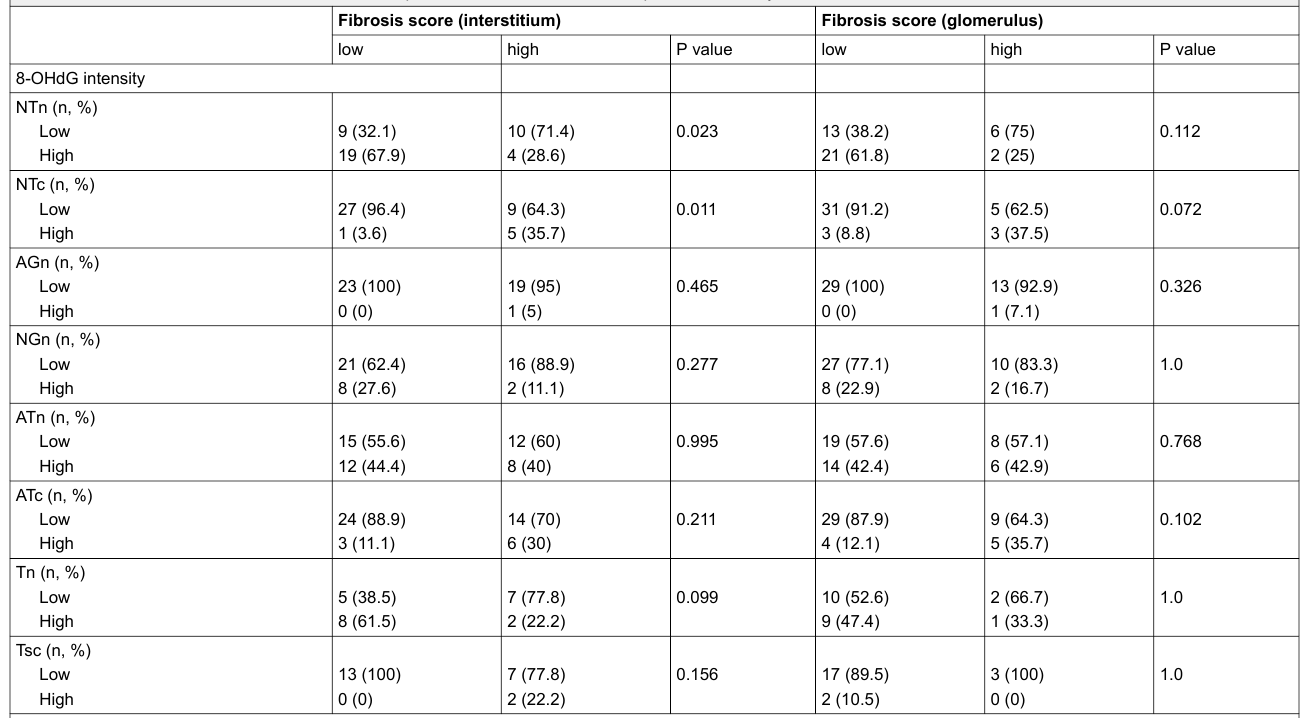
Table 3: Association between fibrosis scores and expression of 8-OHdG in different portions of kidneys. Fibrosis score (interstitium) Fibrosis score (glomerulus) low high P value low high